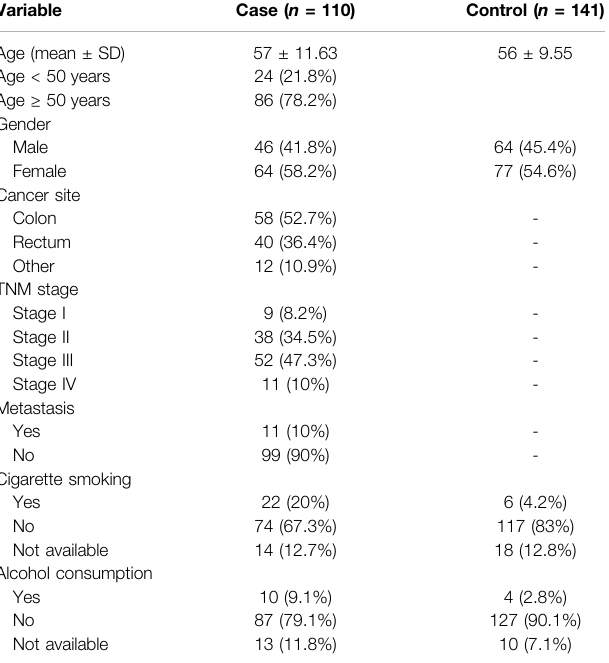
TABLE 1 | Clinical characteristics of patients with CRC and the control group.